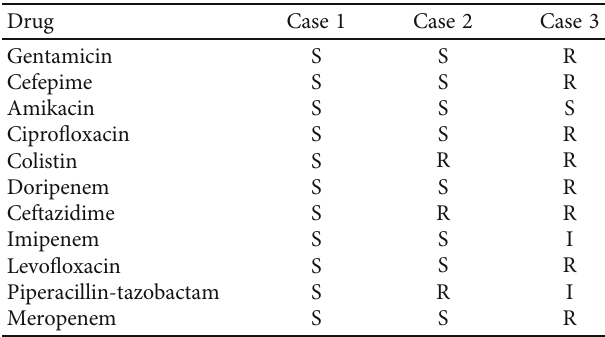
Table 2: Drug sensitivity patterns of Pseudomonas isolates of three cases by microdilution with microblot